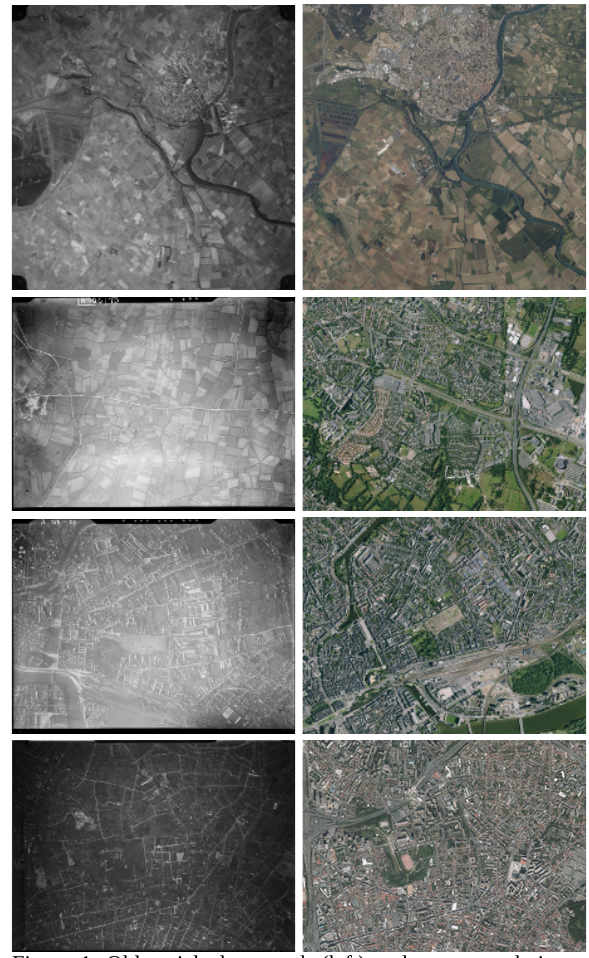
Figure 1. Old aerial photograph (left) and current orthoimage (right) of the same areas. From top to bottom : Agde, Nantes_1, Nantes_2, Saint-Mandé. Main modifications are the important urbanization and roundabouts for Nantes_1, the shipyard replacement by buildings and the river covering (bottom of image) for Nantes_2, the motorway construction (top left of image) and the field urbanization (right of image) for Saint-Mandé, and the modification of most buildings in all